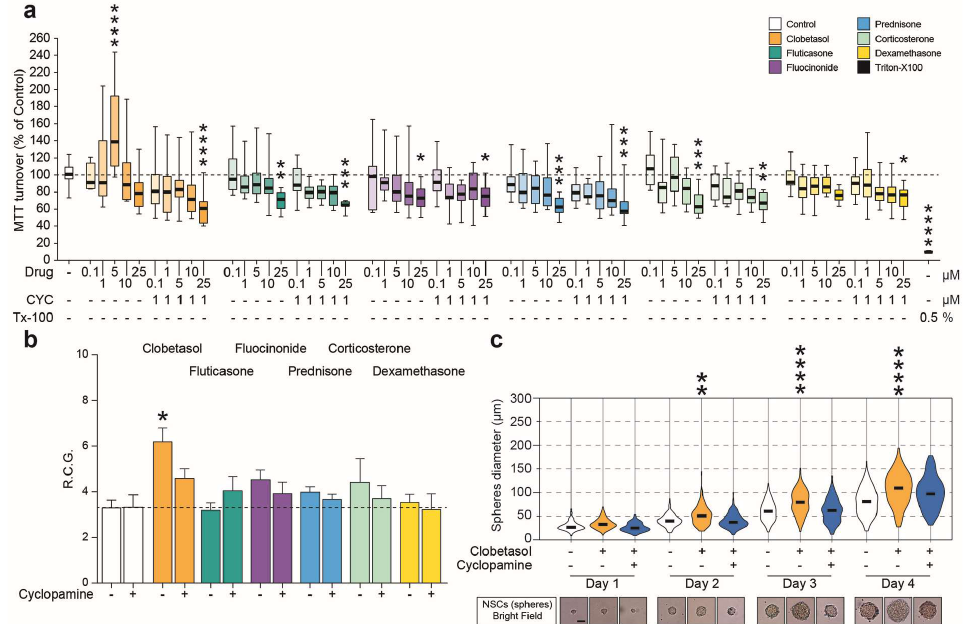
Figure 5. Clobetasol increases proliferation and neurosphere dimension. ( a ) MTT turnover on NSCs under treatment with glucocorticoids with potential activity on Shh pathway (Clobetasol, Fluticasone and Fluocinonide), and control glucocorticoids treatment (Prednisone, Corticosterone and Dexamethasone, all lacking Smo activity). Data are mean numbers ( ± SEM) from n ≥ 3 independent experiments. * p -value < 0.05, ** p -value < 0.01, *** p -value < 0.001 and **** p -value < 0.0001 vs. control. ( b ) NSCs rate of cell growth (RCG) after stimulation with glucocorticoids (5.0 µ M). Cyclopamine was used to inhibit the e ff ects on the Shh pathway. Data are mean numbers ( ± SEM) from n ≥ 3 independent experiments. ** p -value < 0.01 vs. untreated control. ( c ) Violin plot of the NSCs spheres diameter expressed in µ m from day 1 to day 4 under Clobetasol treatment in vitro. Scale bar: 50 µ m. Data from n ≥ 3 independent experiments. ** p -value < 0.01, **** p -value < 0.0001 vs. day control. Statistical analysis has been performed by using ANOVAs followed by Sidak post-hoc